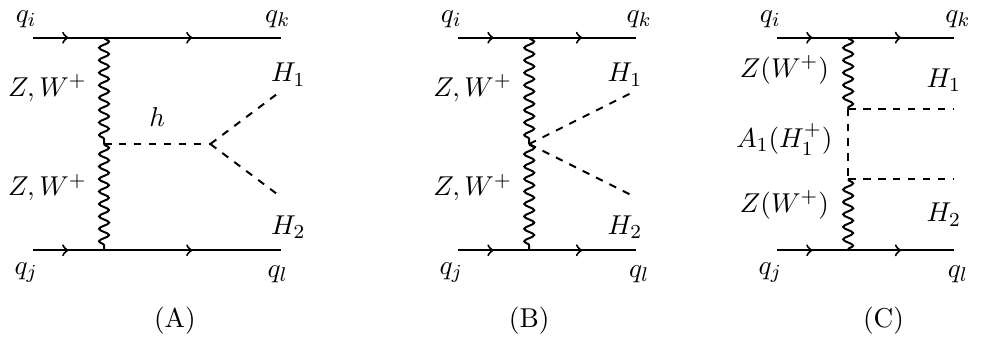
Figure 8 . Diagrams leading to the (cid:0) E T + f (cid:22) f (cid:12)nal state via VBF